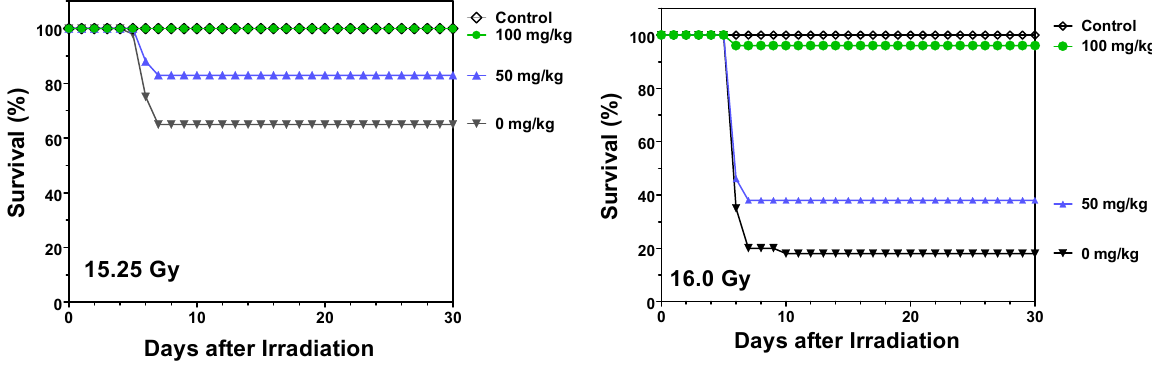
Figure 5. Pre- and post-radiation treatment with multiple-dose opaganib improves survival of partially shielded irradiated mice. C57BL/6 mice were orally treated with 0 ( ▼ ), 50 ( ▲ ) or 100 ( ● ) mg/kg opaganib 4 h before being exposed to 15.25 (Left Panel) or 16.0 (Right Panel) Gy irradiation with 5% bone marrow shielding. Control mice did not receive opaganib or radiation ( ◊ ). Mice were treated with opaganib twice daily at the same dose as their initial treatment for a total of 3 days after radiation. Mice were monitored for survival for 30 days.